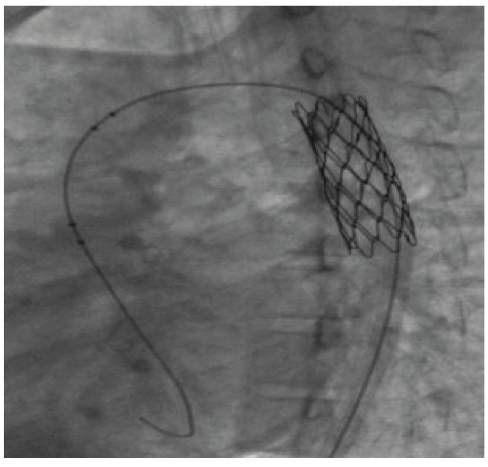
Figure 1: Aortography showing the stent in